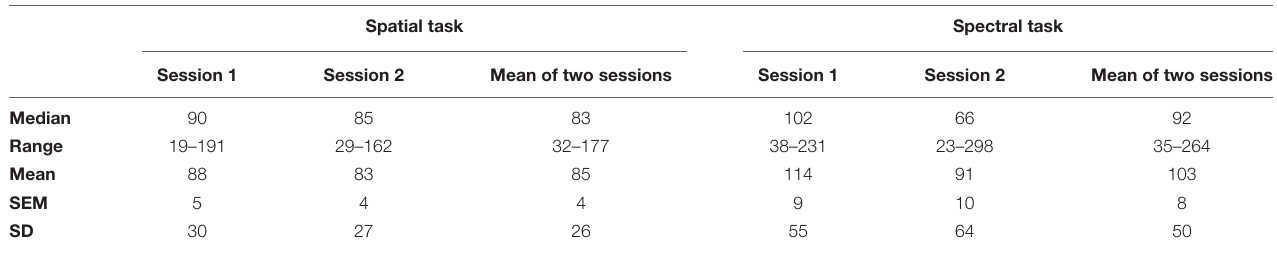
TABLE 1 | Descriptive statistics of the ATOT values (in ms) in two consecutive sessions for spatial (monaural presentation of paired clicks) and spectral (binaural presentation of paired tones)